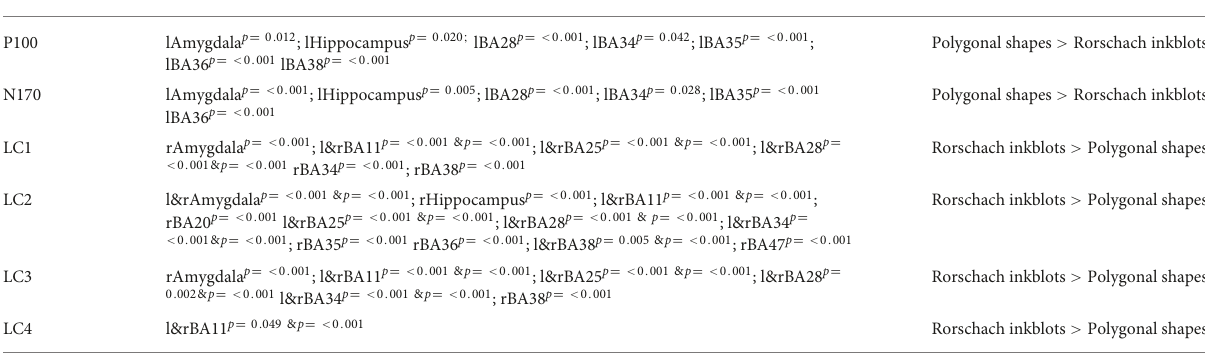
TABLE 2 Paired t -test between the mean intensity during the Rorschach inkblots vs. polygonal shapes for each left (l) and right (r) frontal (BA: 4-6-8-9-10-11-44-45-46-47), parietal (BA: 1-2-3-5-7-39-40-43), temporal (BA: 20-21-22-37-38), cingulate (BA: 23-24-25-29-30-31-32-33), and limbic areas (amygdala, hippocampus, BA: 13-28-34-35-36) in each interval: P100, N170, LC1, LC2, LC3, and LC4 (Bonferroni correction was applied). Intervals